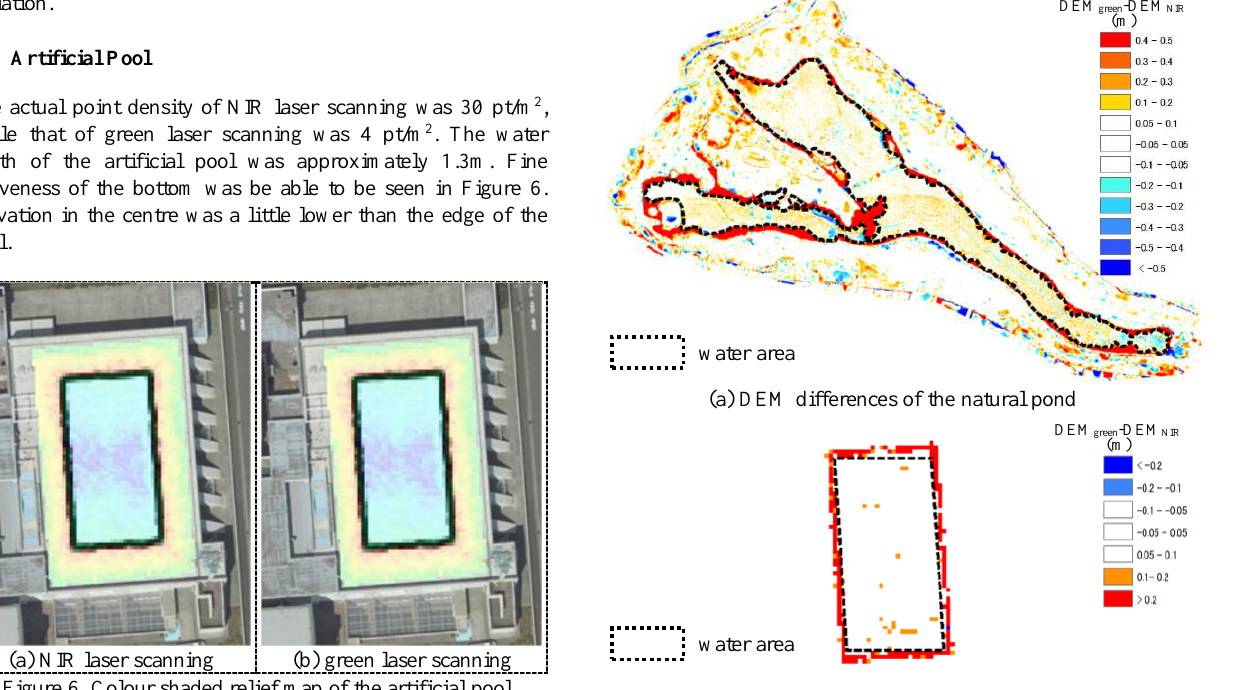
Figure 7. DEM differences between NIR laser scanning and